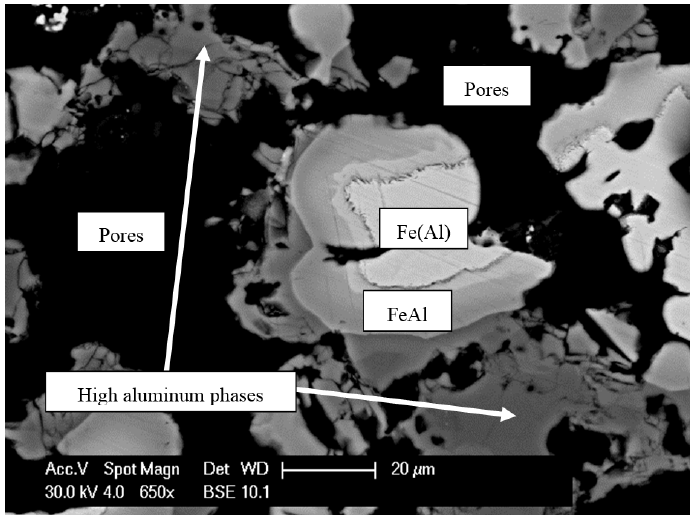
Figure 5. Result of EDS analysis in micro areas of material after the sintering process (Fe–45Al–3 wt%